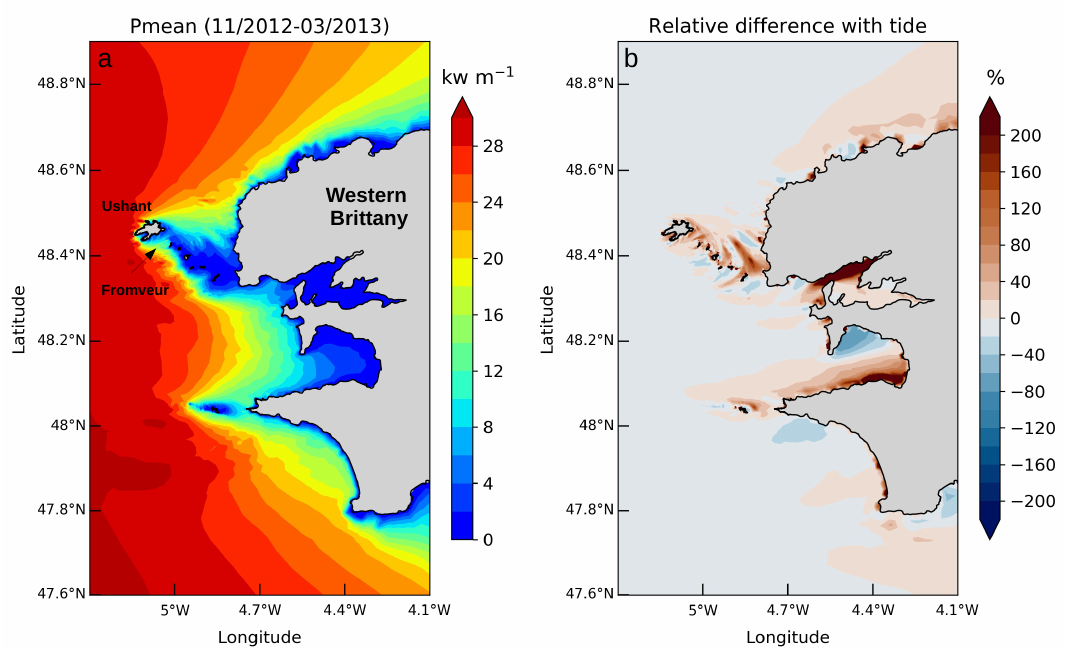
Figure 7. ( a ) Averaged wave power, in western Brittany (France), between November 2012 and March 2013 without tide and ( b ) relative differences (with respect to the configuration without tide) obtained with the inclusion of tide. Positive and negative values account for increase and reduction of predicted values with tide, respectively—adapted from